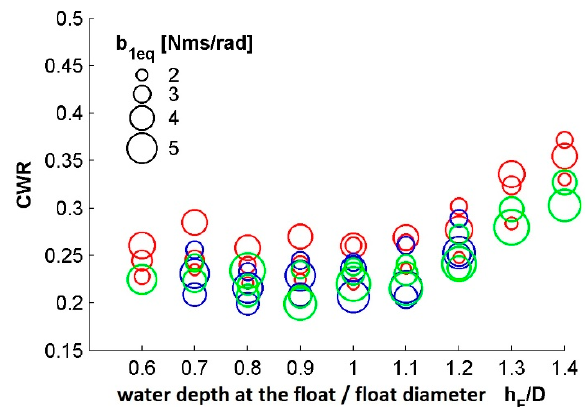
Figure 10. CWR of EDS as a function of flat damping b 1eq , distance between paddle and float d P-F / D , water depth at the float h F / D . Red circles, d P-F /D = 0.8; blue circles, d P-F /D = 1.1 ; green circles d P-F /D = 1.4. Wave B.